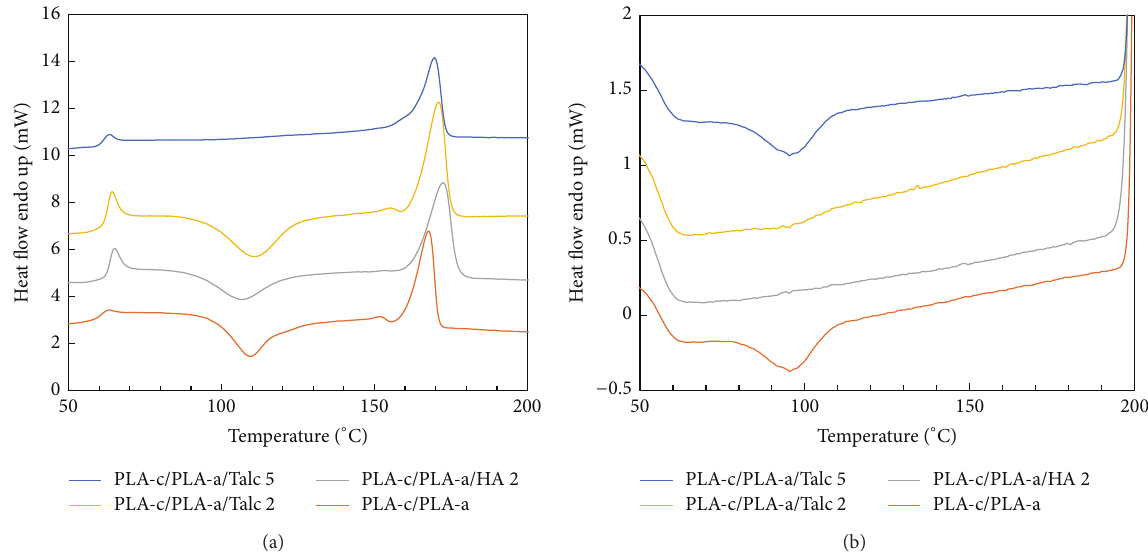
Figure 5: Effect of the weight percent of the filler on DSC result of heating (a) and cooling (b) of the blends of crystalline PLA and amorphous PLA (PLA-c/PLA-a).